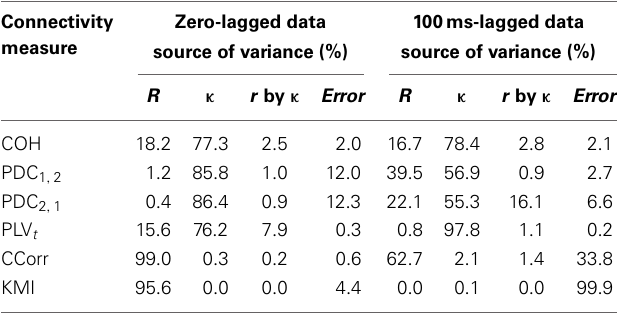
Table 1 | Showing the proportion of variance accounted in each connectivity measure by correlation and